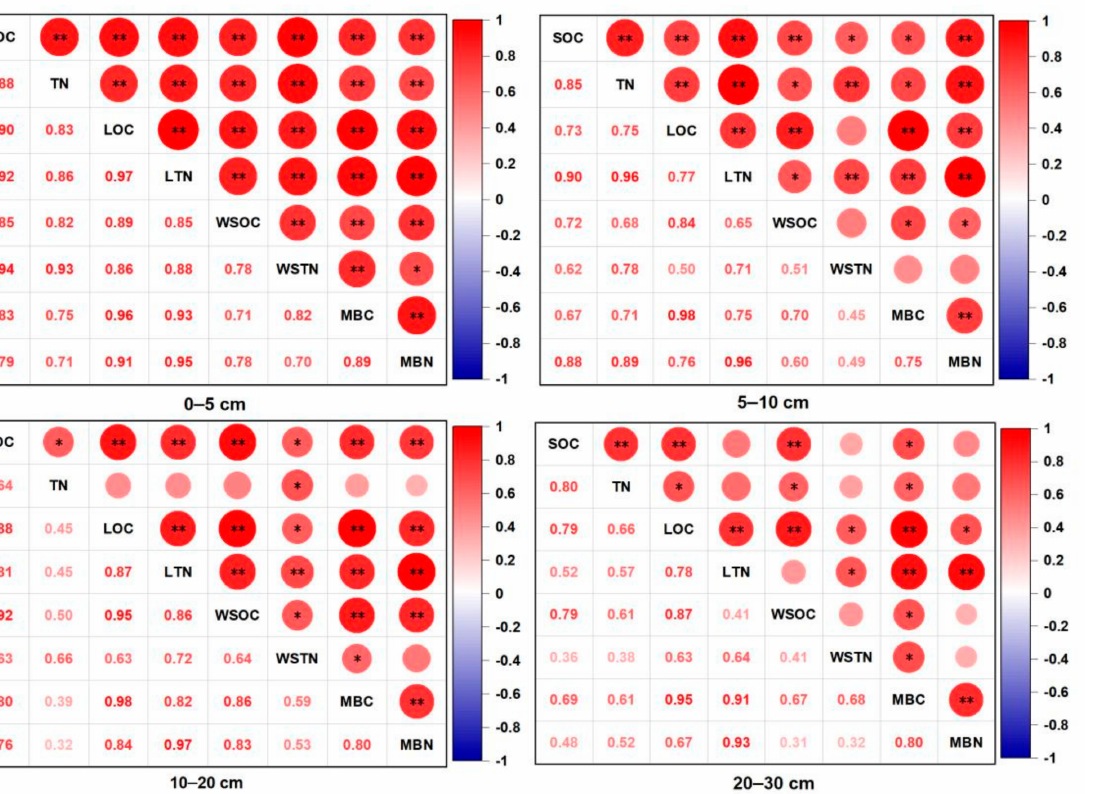
Figure 8. Correlation analysis of different soil C and N fractions at a depth of 0–30 cm. Red and blue circles represent positive and negative correlation, respectively. The size of the circle is proportional to the r value. *, p < 0.05; **, p < 0.01. The correlation coefficients are in the lower left panel. SOC: soil organic C; TN: total N; LOC: labile organic C; LTN: total labile N; WSOC: water-soluble organic C; WSTN: total water-soluble N; MBC: microbial biomass C; MBN: microbial biomass